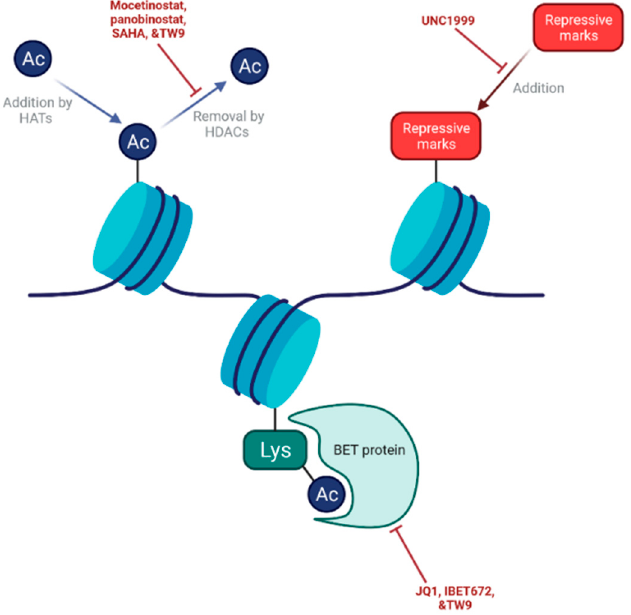
Figure 5. Epigenetic targets and drugs in PDAC. Much research has focused on histone deacetylase (HDAC) inhibitors, which have the potential to abolish cellular plasticity through the reversal of epigenetic states. However, both mocetinostat and Panobinostat failed in clinical trials. Bromodomain and extra ‐ terminal domain (BET) proteins, which play key roles in the modulation of gene expression through binding to acetylated lysine residues, are alternative targets. In vitro and in vivo pre ‐ clinical models have demonstrated the efficacy of BET inhibitors I ‐ BET 627 and JQ1. UNC1999, an inhibitor of writers for H3K9me2 and H3K7me3 repressive markers, has also achieved promising results in organoid models.